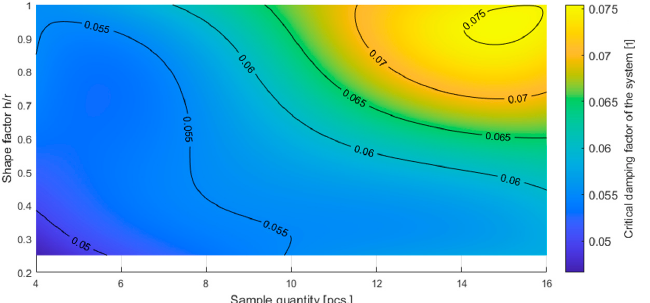
Figure 13. Critical damping factor of the tested system as a function of the quantity of the sample and shape factor of individual samples.